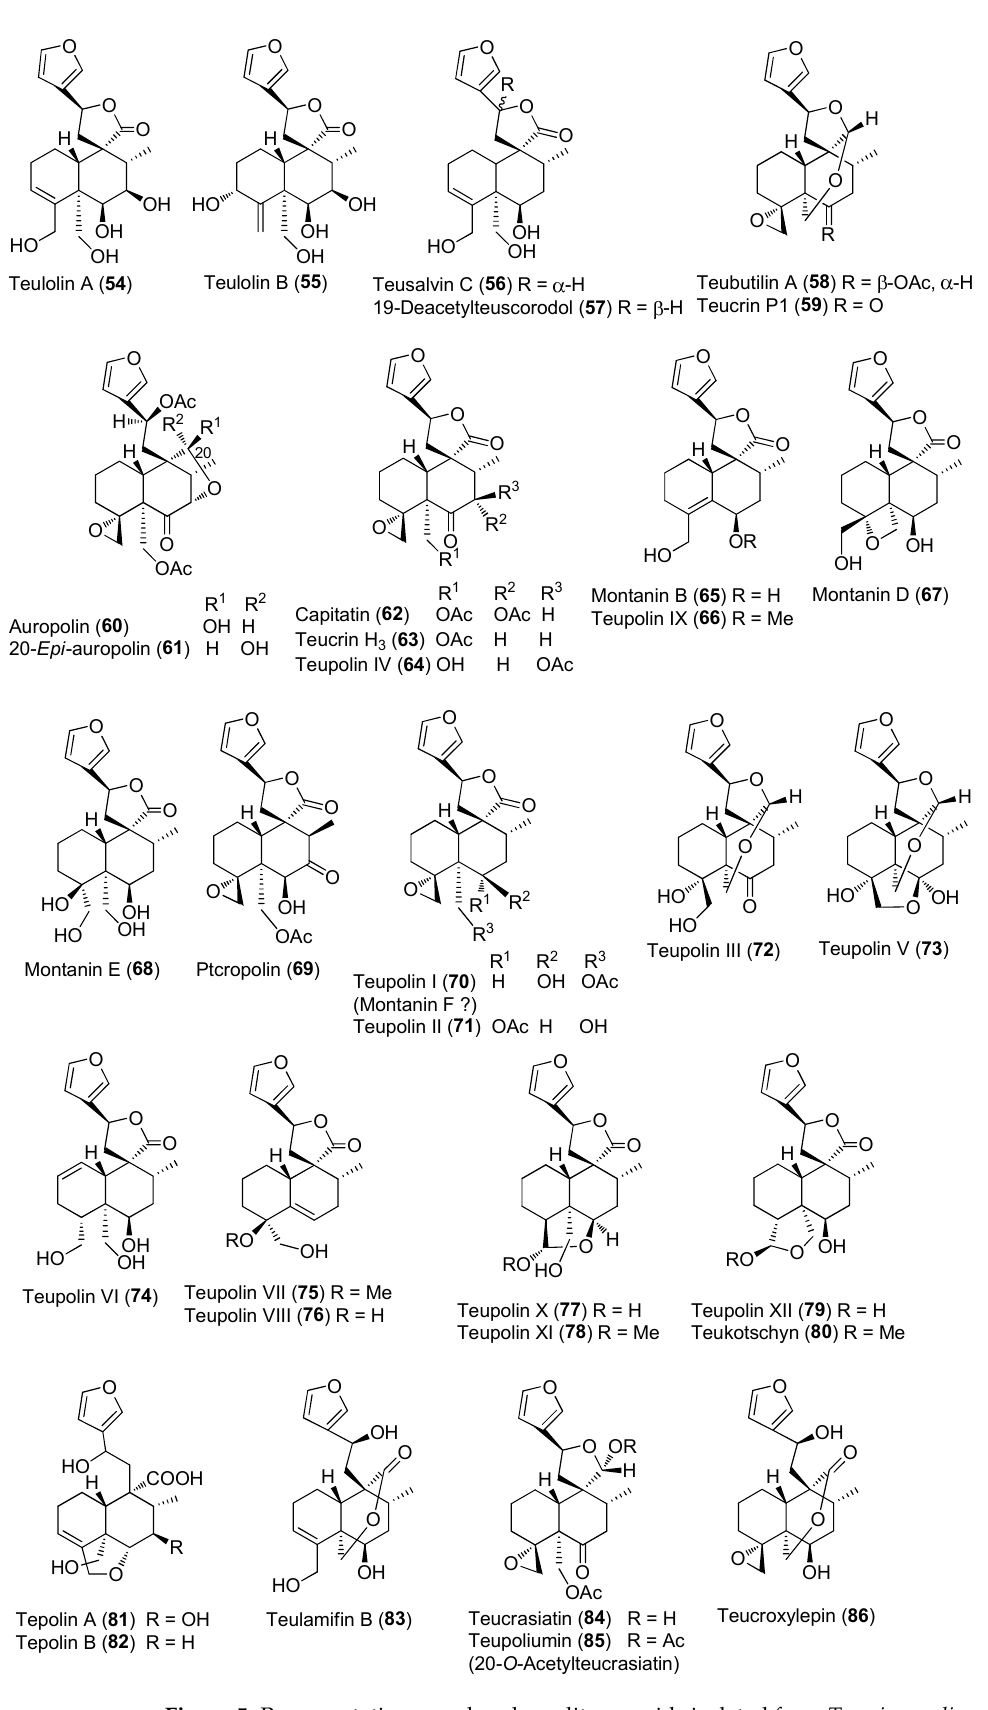
Figure 5. Representative neo-clerodane diterpenoids isolated from Teucrium polium .